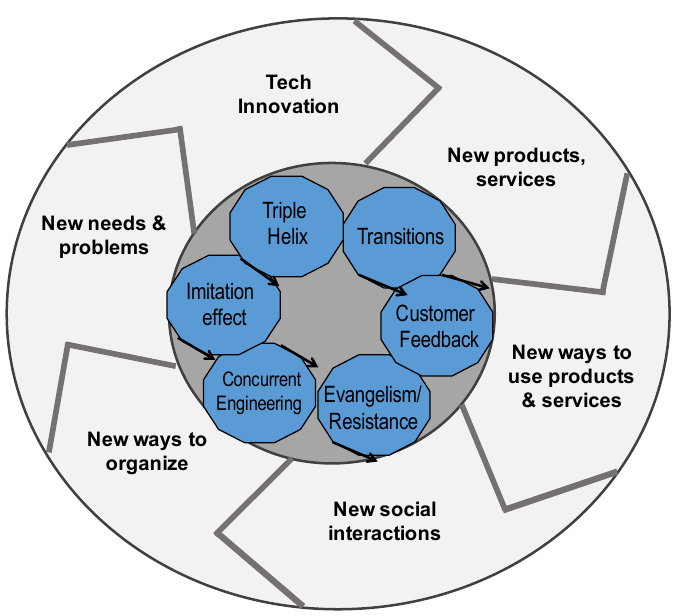
Fig. 3. Nonlinear innovation models portrayed as epicycles within the Circle of Innovation The Circle of Innovation highlights how innovations change society and lead to demand for further innovations. It suggests a distinction between innovations